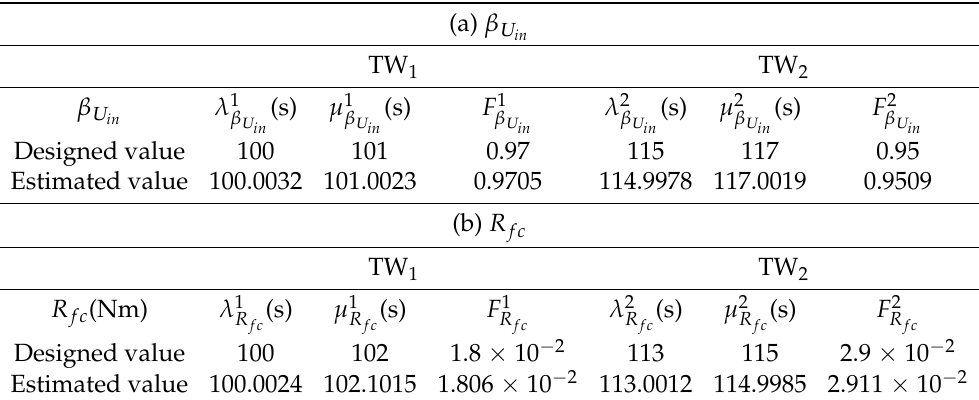
Table 4. Comparison of designed values and estimated